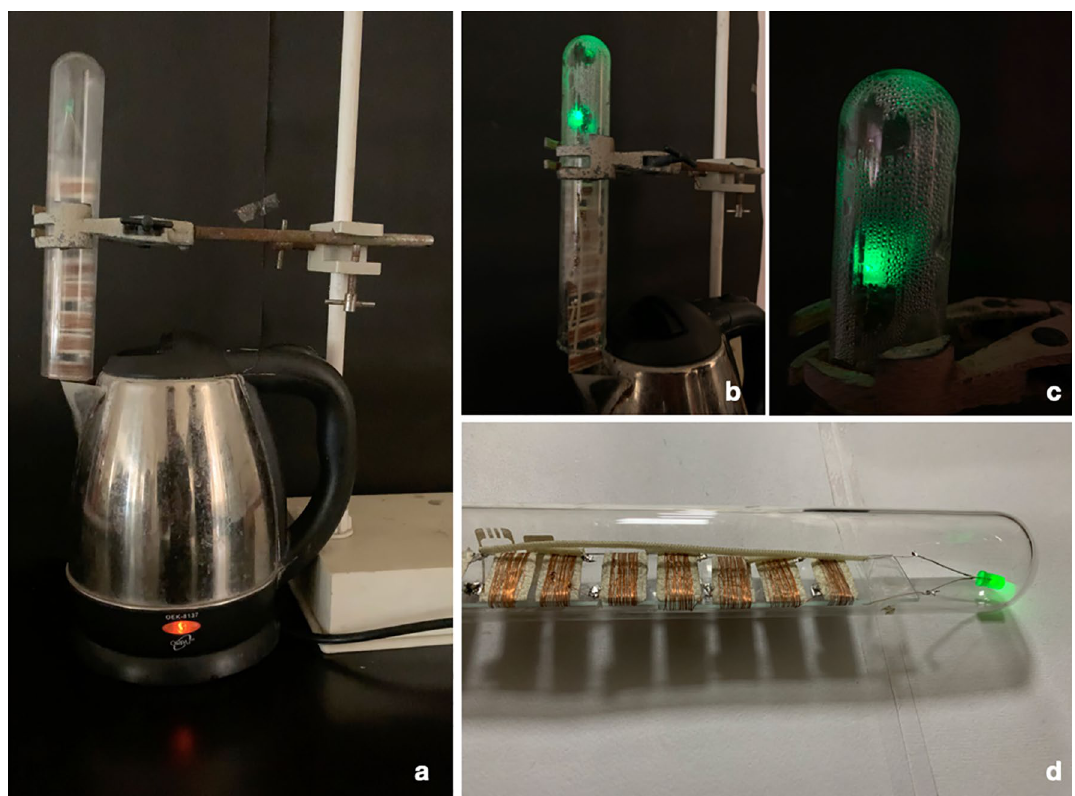
( d ) The device, after removal from the water vapor